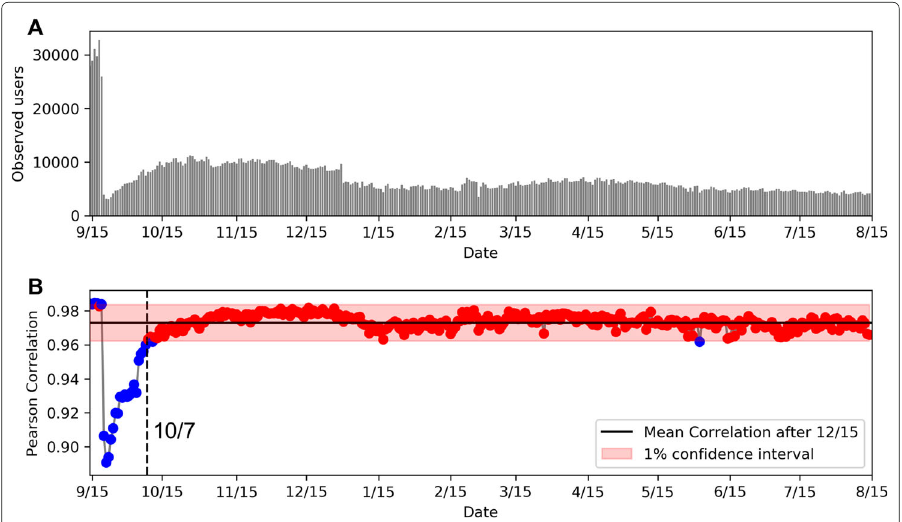
Fig. 3 Fragmentation of mobile phone location data due to power outages. a Number of observed mobile phone users over time b Correlation between census population and number of observed mobile phone users who live in each county, across all